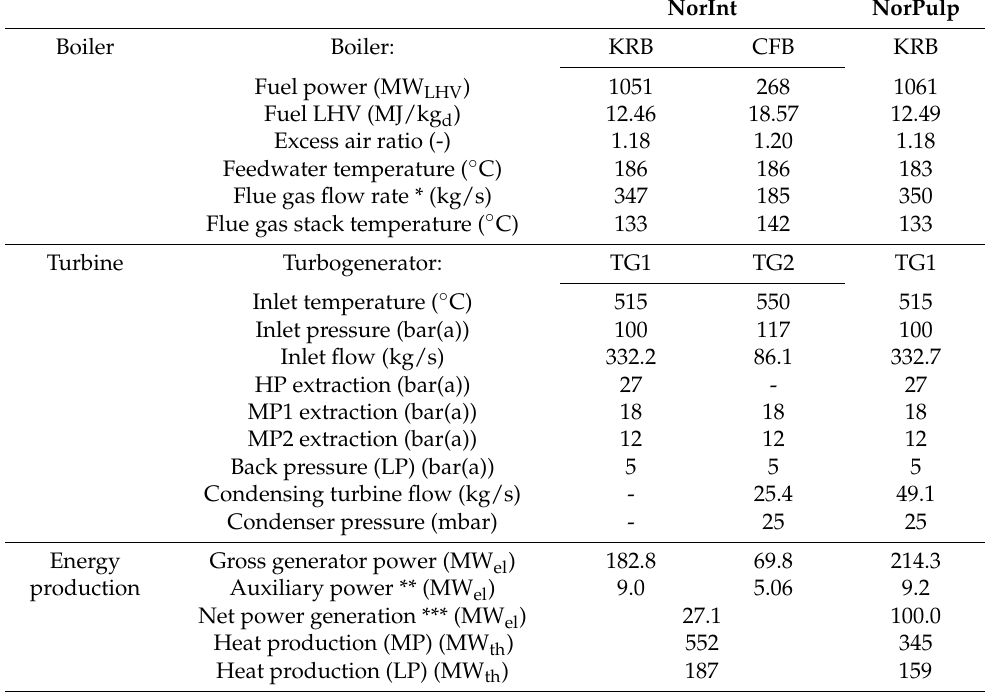
Table 2. Operating data of the considered